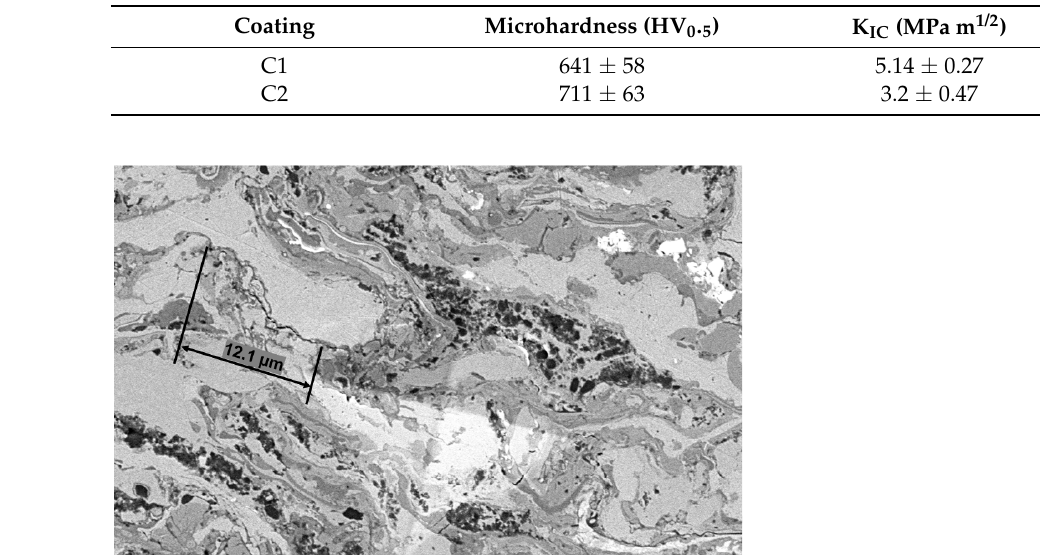
Table 3. Mechanical properties of coatings.